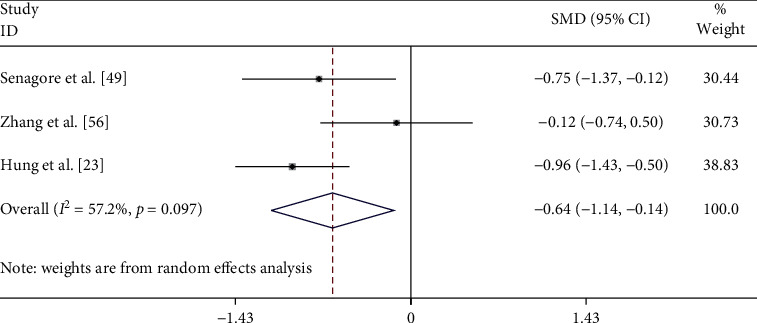
Forest plot of comparison of intraoperative fluid infusion. SMD = standard mean difference.